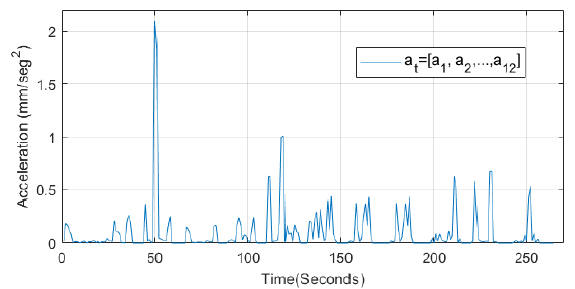
Figure 3. A vector with a collection of HR acceleration of each ECG.